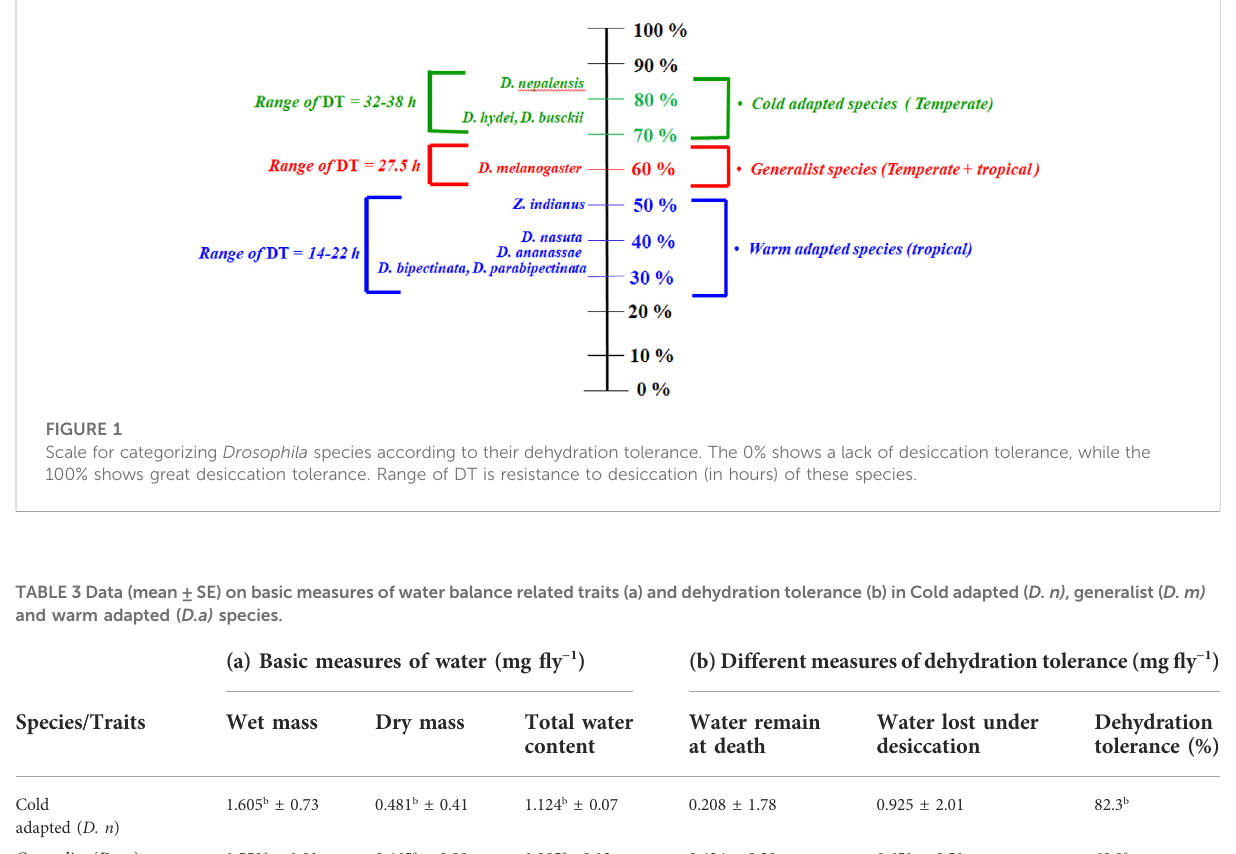
Water lost under Dehydration at death desiccation tolerance (%)